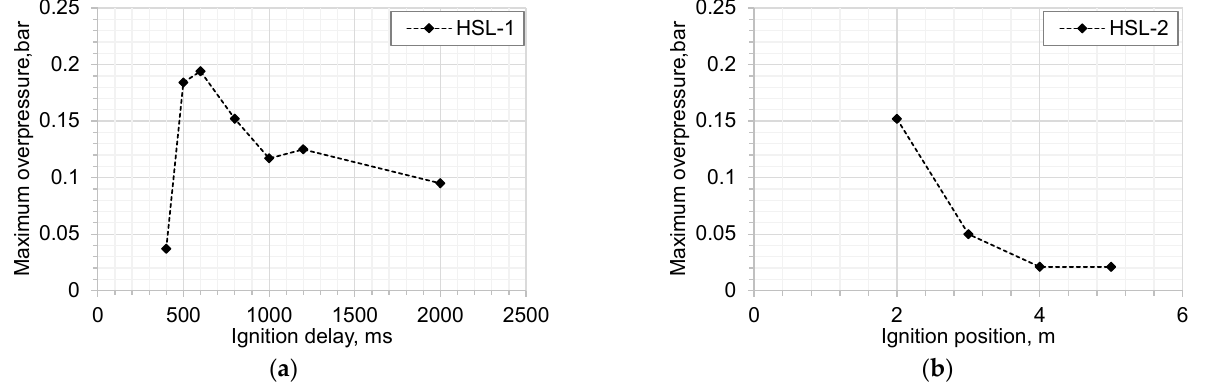
Figure 1. Blast wave overpressure from delayed ignition of a turbulent hydrogen jet from 20 MPa storage through 6.4 mm nozzle: ( a ) effect of ignition delay for a fixed ignition position at 2 m from the nozzle along the jet axis; ( b ) effect of ignition position for a fixed ignition delay time of 0.8 s [3].